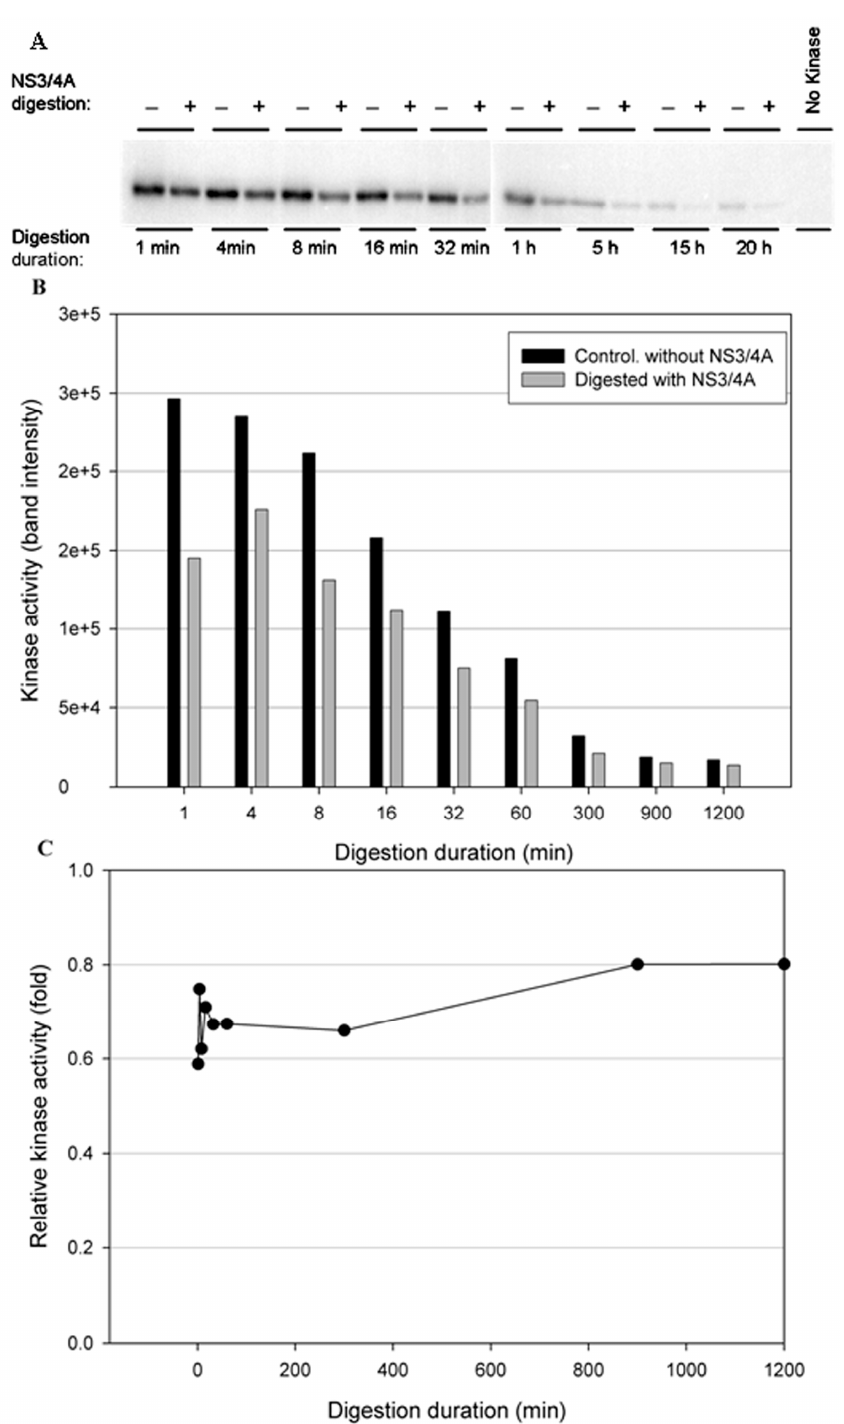
Figure 5. Effect of the proteolytic activity of NS3/NS4A on IKK β kinase activity in a time-dependent manner. The kinases (0.5 μ g) were treated with NS3/NS4A (1.25 μ M NS3 + 325 μ M NS4A). ( A ) IKK β was treated with or without NS3/4A for up to 20 h. The kinase activity was tested using GST-I κ B α (residues 5–55) and [ γ - 32 P]ATP as substrates. Phosphorylated GST-I κ B α bands were detected by a PhosphoImager. ( B ) The band intensities detected by the PhosphoImager were plotted versus time. ( C ) The relative kinase activities (IKK β treated with NS3/NS4A versus untreated control) were plotted versus time.